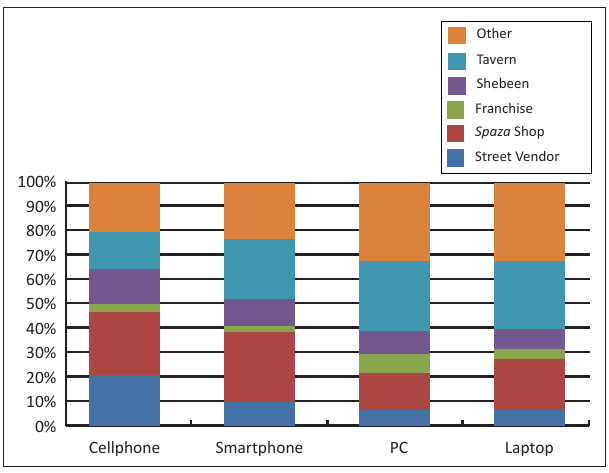
FIGURE 10: Correlation between information and communications technology usage and type of business.